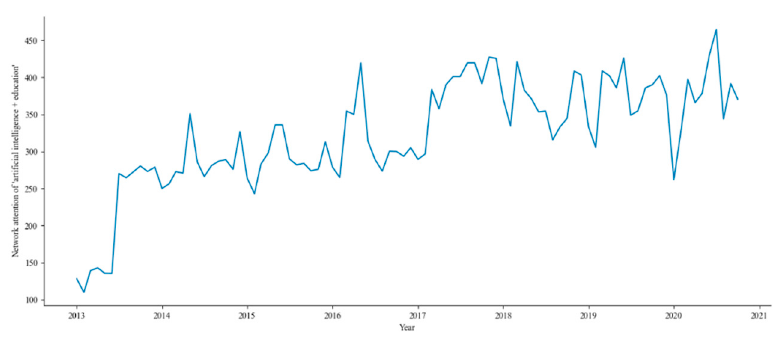
Figure 5. Total Baidu search index value of “AI + education” in Guizhou province. Figure 6 is a diagram of the original sequence converted by the difference method.